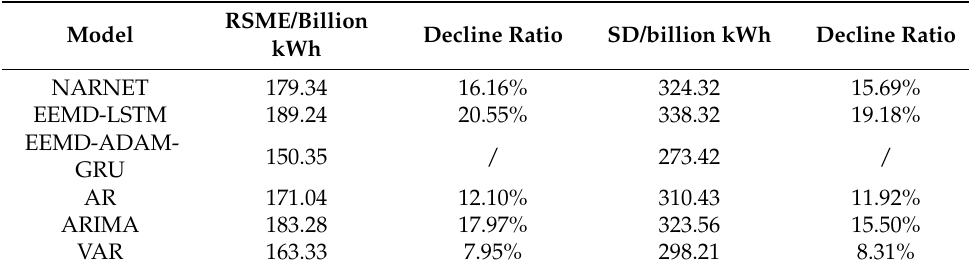
Figure 6. Comparison of predicted values of different models. Table 3. Comparison of prediction performance in test set.